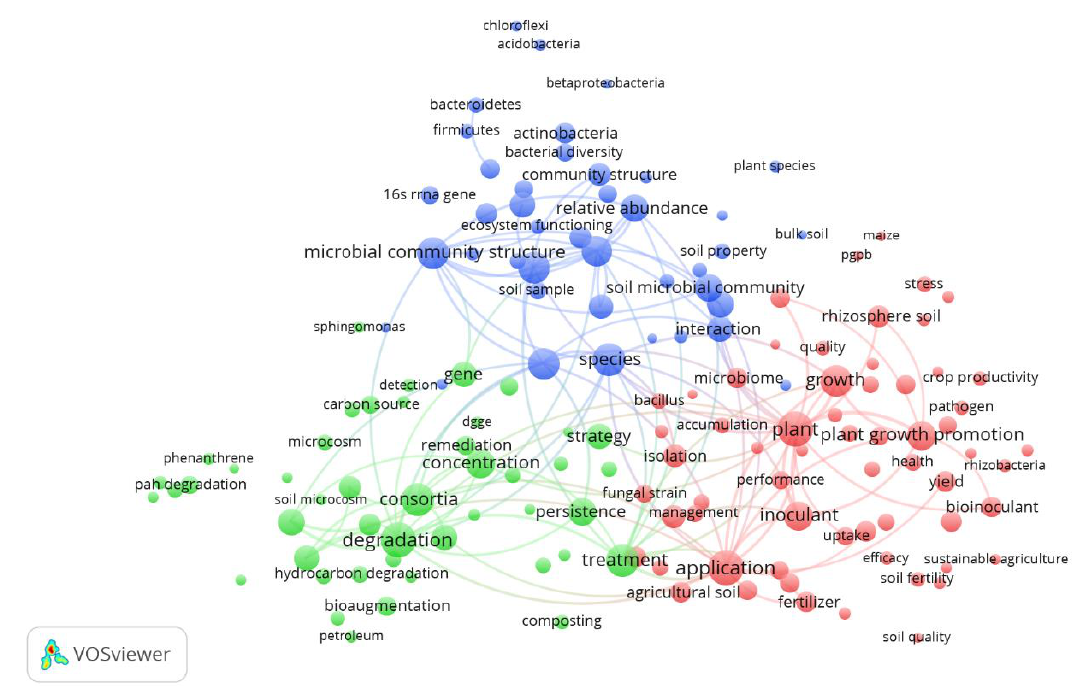
Figure 5. The terms clustering map based on the Scopus soil microbial inoculants publications from 2015 to 2020. Different colors (red, green, blue) represent the terms belonging to different clusters. The size of the term is based on the number of occurrences. The connecting lines indicate the 100 strongest co-occurrence links between terms.